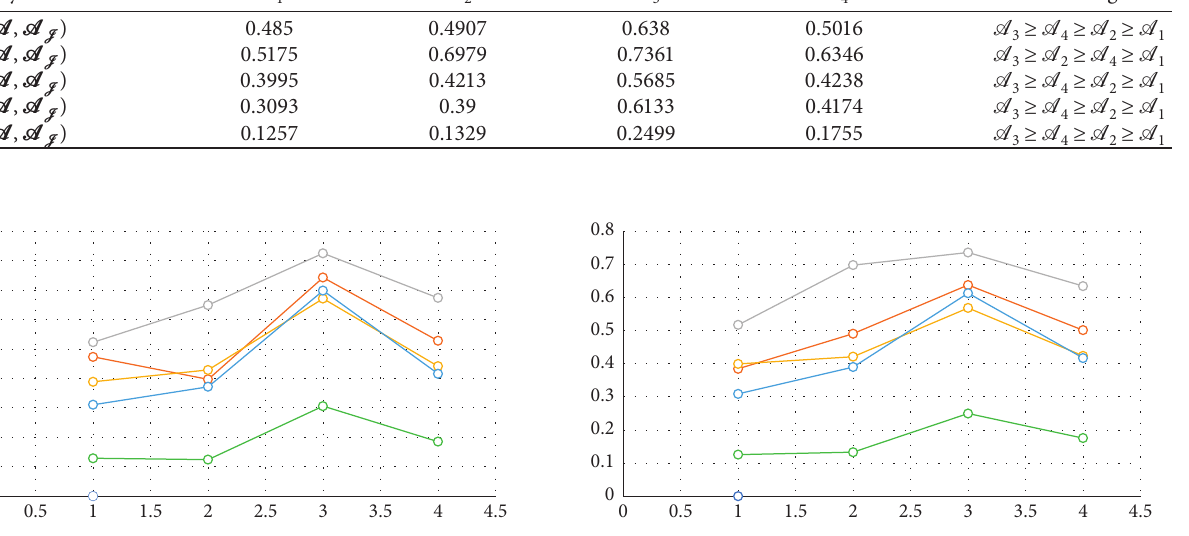
Figure 2: The graphical portrayal of the interpreted WSMs be- tween A and A J ( J � 1 , 2 , 3 , 4 )